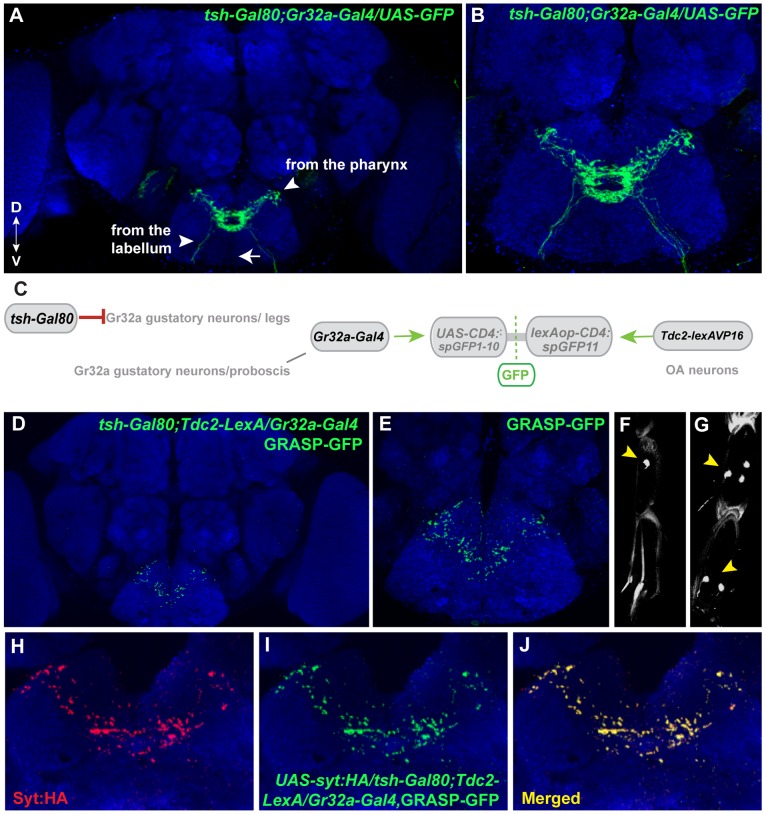
Mouth-specific Gr32a neurons contact OA neurons in the suboesophageal ganglion.(A) Axons of Gr32a-expressing neurons located in the mouth identified by immunofluorescence to CD8:GFP in tsh-Gal80;UAS-CD8:GFP/Gr32a-Gal4 progeny (green, anti-CD8, Invitrogen). Note the absence of axonal projections from the legs via the thoracic ganglion (arrow, compare to Figure 1A). (B) Higher magnification of Gr32a mouth neurons expressing CD8:GFP. (C) Schematic representation of the GRASP reporter lines combined with the tsh-Gal80;Gr32a-Gal4 and Tdc2-lexA driver lines. Gal80 driven by the tsh-Gal80 line prevents Gal4 activity and subsequent expression of the UAS-CD4::spGFP1-10 GRASP reporter. (D–E) Two different confocal image magnifications of a male brain with the same number of optical sections as in panel A. A reduced amount of GRASP-mediated GFP reconstitution is observed reflecting Gr32a neurons located only in the mouth expressing CD4::spGFP1-10 and OA neurons expressing CD4::spGFP11. GRASP reconstitution is detected by immunofluorescence using rabbit monoclonal GFP antibody (green; Life Technologies). (F–G) tsh-Gal80 blocks GFP expression in Gr32a-expressing leg neurons. Less than one neuron per leg of UAS-nlsGFP; teashirt-Gal80/Gr32a-Gal4 progeny is observed (arrowhead, 0.38 neurons per front leg, n = 8), versus males without Gal80 expression (arrowhead, 5 neurons per front leg, n = 8). (H–J) Optical sections of a female brain (UAS-syt:HA; tsh-Gal80;UAS-CD8:GFP/Gr32a-Gal4) at higher magnification showing GRASP-mediated GFP reconstituted expression (I), syt:HA localization (H) and clear overlap or close association at synaptic-like puncta in the merged channel (J).